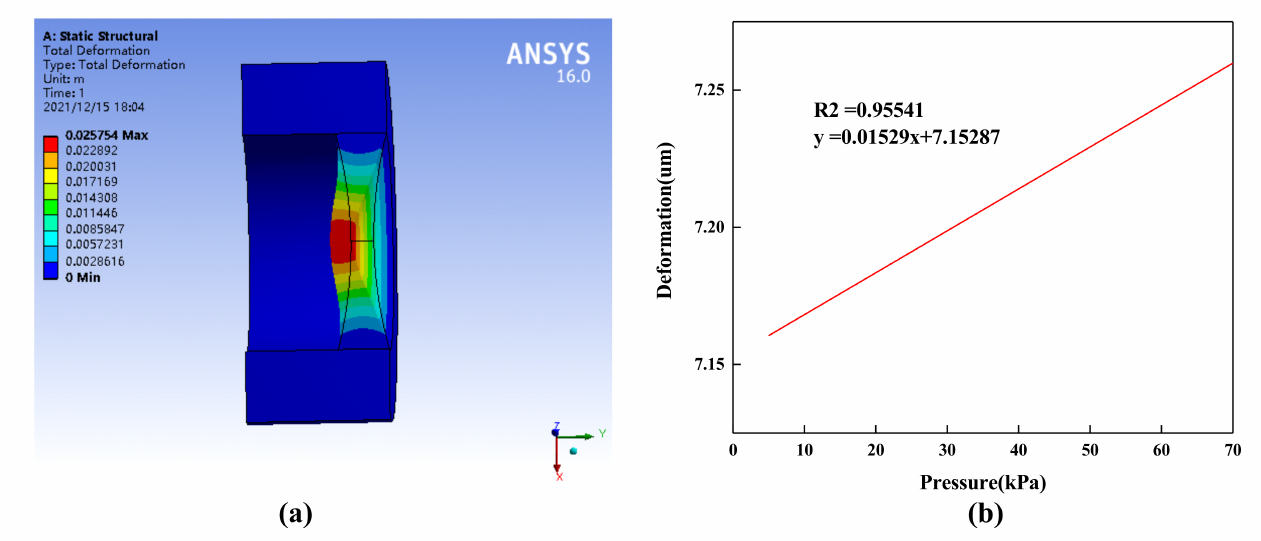
Figure 2. Stress and deformation of thin-film at external air pressure: ( a ) Simulation diagram made at 5000 Pa; ( b ) Deforma- tion of the diaphragm for different pressure